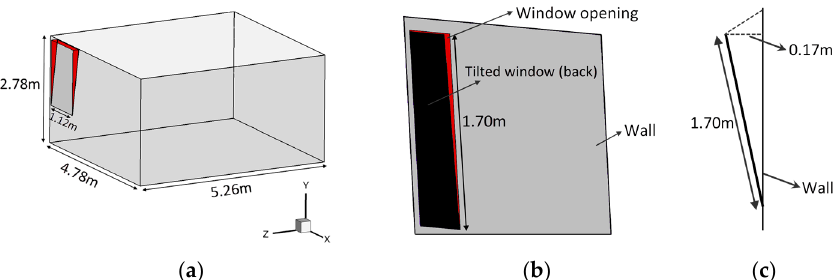
Figure 4. Replication and dimensions of: (a) the room, (b) window and (c) window’s opening.